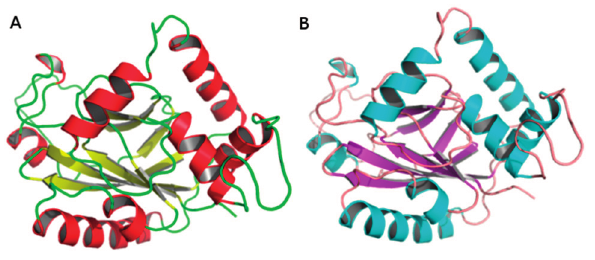
Figure 1. Models of HSV-1 protease generated by SWISS-MODEL and Modeller softwares. ( A ) Model obtained with Modeller software and ( B ) Model obtained with SWISS-MODEL